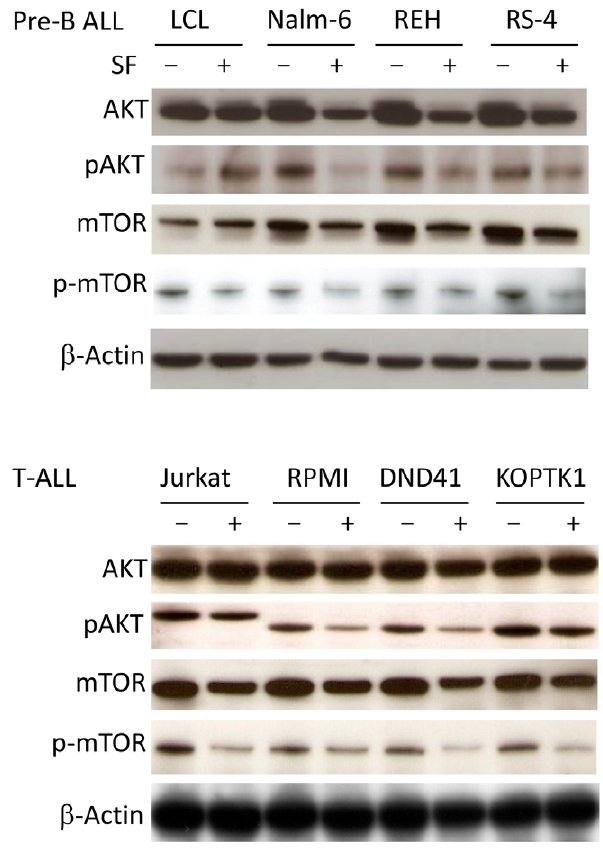
Figure 5. SF inhibits the AKT/mTOR survival pathway in leukemic cells. The protein levels of phosphorylated and total AKT and mTOR were examined by immunoblotting. LCL, pre-B ALL, and T- ALL cell lines were incubated with 7.5 m M SF or vehicle for 24 hours. b - actin was used as a loading control. The data are representative of three independent